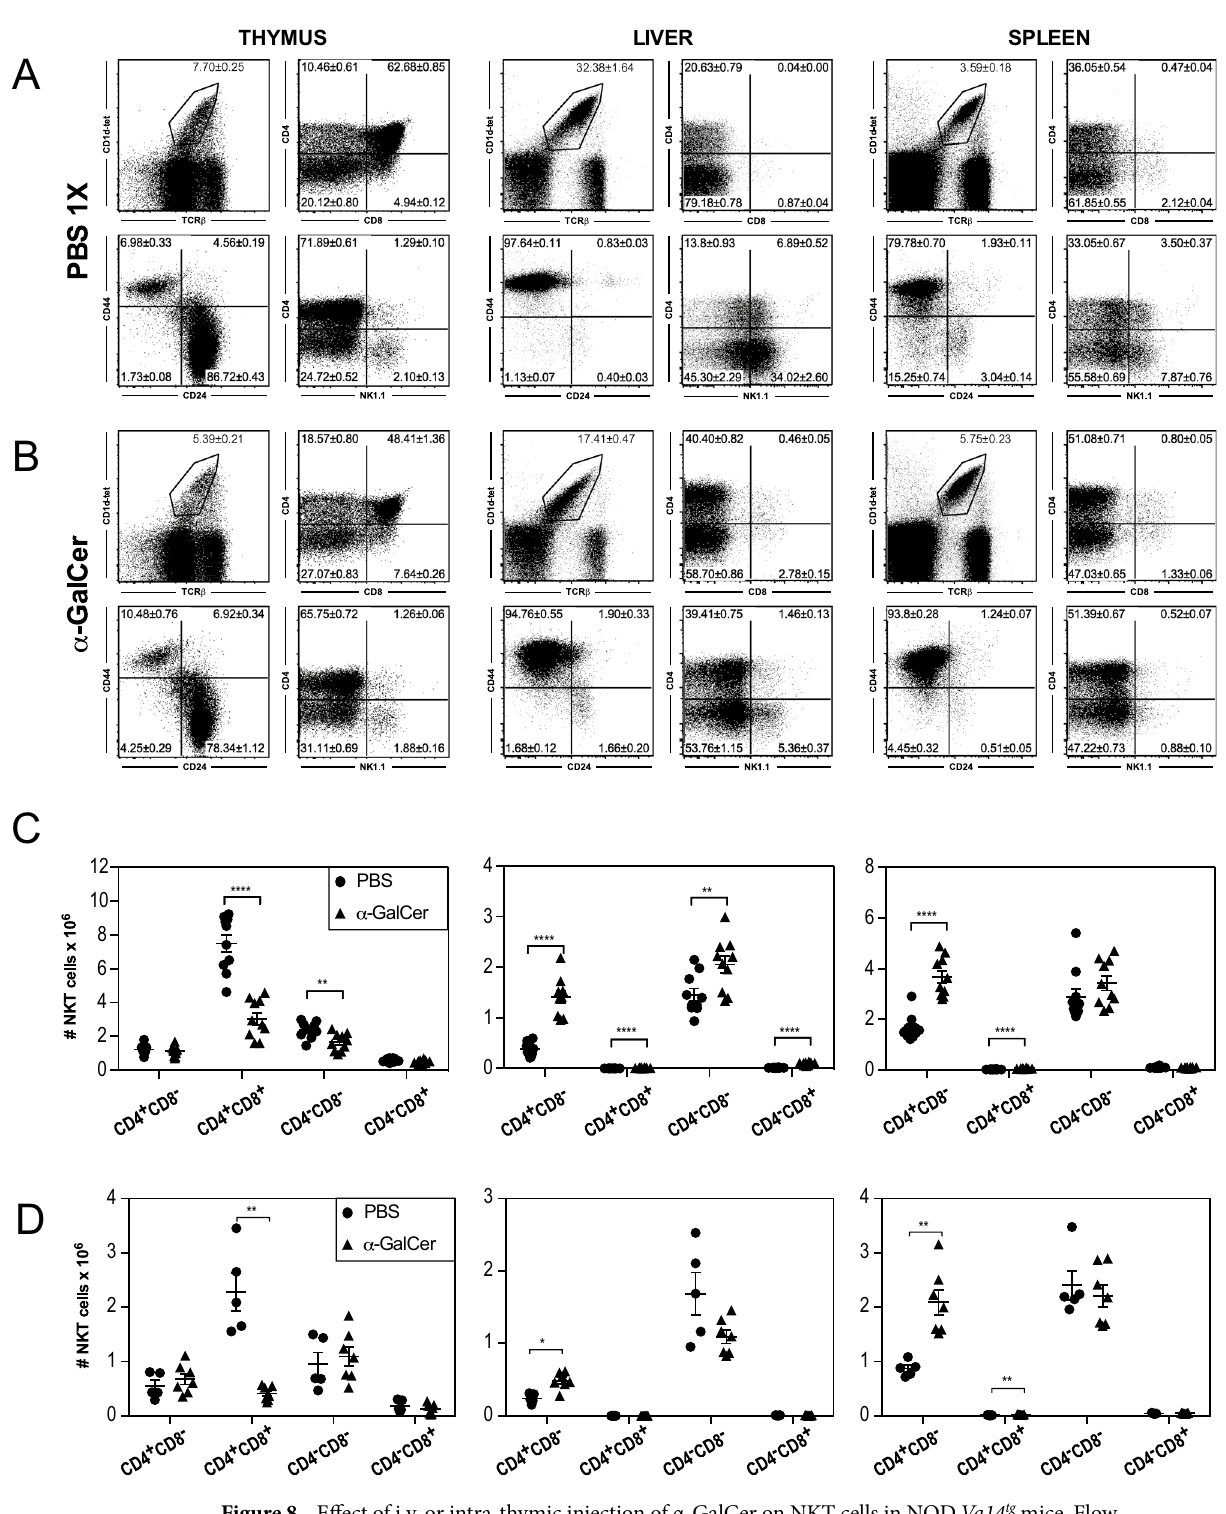
Figure 8. Effect of i.v. or intra-thymic injection of α-GalCer on NKT cells in NOD. Va14 tg mice. Flow cytometric comparison of the effects of i.v. injection with PBS ( A ) or α-GalCer ( B ) on thymic, hepatic and splenic NKT cell proportions, subsets ( A , B ) and absolute numbers ( C ) in NOD. Va14 tg /1 mice (**P < 0.01; ****P < 0.0001; Mann–Whitney U Test; n = 10 mice/group). ( D ) Flow cytometric comparison of the effects of intrathymic injection of α-GalCer on absolute numbers in NOD. Va14 tg mice compared to untreated